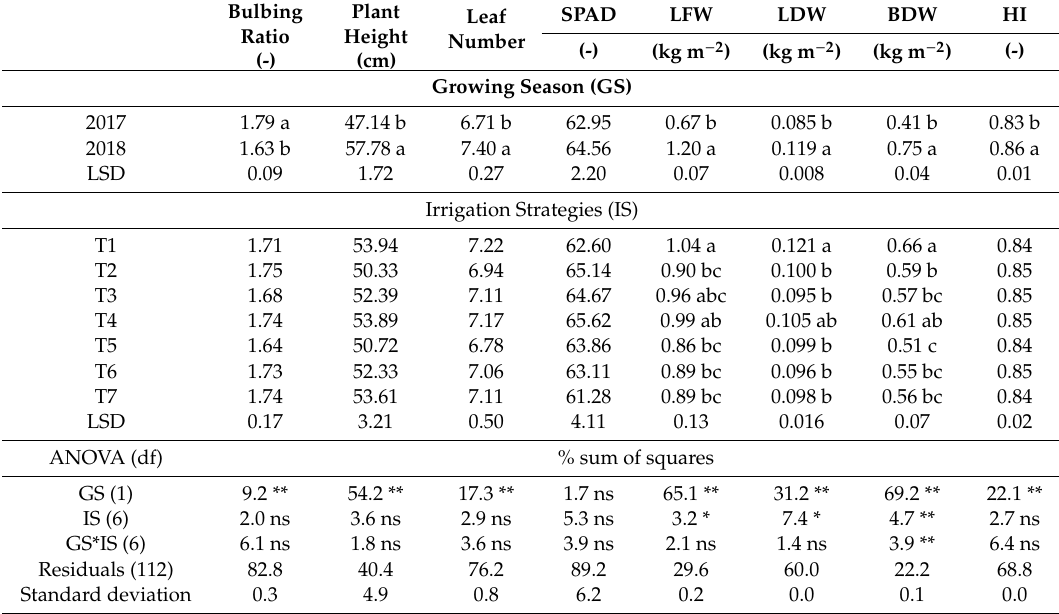
Table 4. E ff ects of the growing season and the irrigation strategy on the bulbing ratio at the end of stage 2, and on the plant height, leaf number per plant, leaf chlorophyll index (SPAD), leaf fresh weight (LFW), leaf dry weight (LDW), bulb dry weight (BDW), and harvest index (HI) at harvesting.